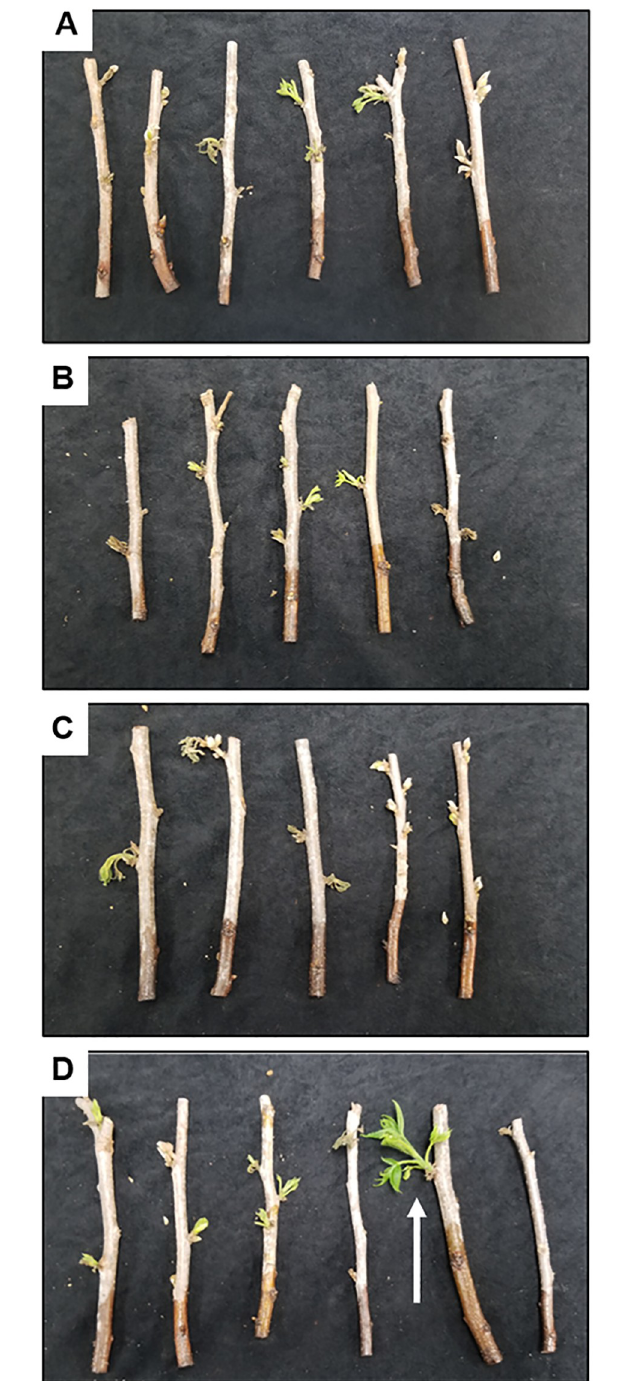
Fig 7. Impacts of thermal treatments on the plant viability. Scions were treated with multi-walled carbon nanotube (MWCNT) or sterile deionized water (dH 2 O) with or without microwave radiation exposure for 3 sec in two iterations (6 sec total). Scions were then incubated on an aeroponic system and monitored for two weeks. Images show the collected scions where initiation of bud-break and axillary outgrowth has occurred. (A) dH 2 O-treated scions without microwave irradiation. (B) dH 2 O-treated scions with microwave irradiation. (C) MWCNT-treated scions without microwave irradiation. (D) MWCNT-treated scions with microwave irradiation. Arrow indicates outgrowth of axillary bud.